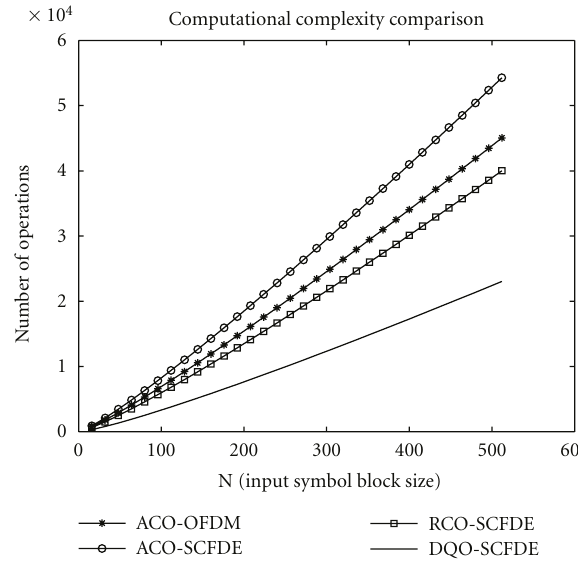
Figure 8: Bandwidth e ffi ciency comparison for ACO-OFDM, ACO-SCFDE, RCO-SCFDE, and DQO-SCFDE with channel delay spread of L = 3 sampling times.